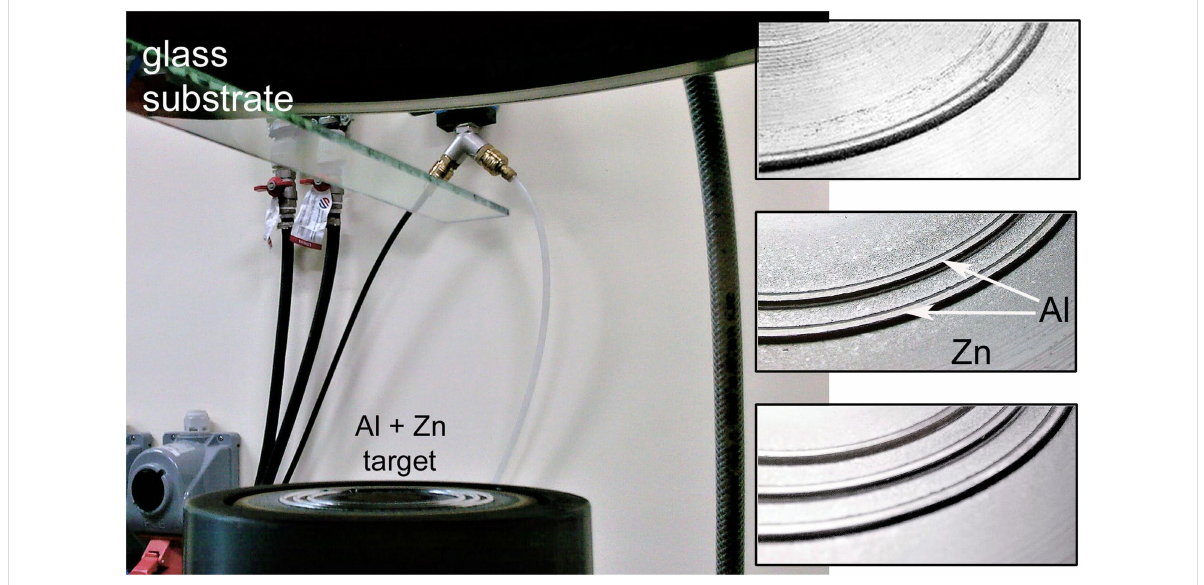
Figure 3: Magnetron source with Zn/Al target and images showing tested arrangements of Al inserts.